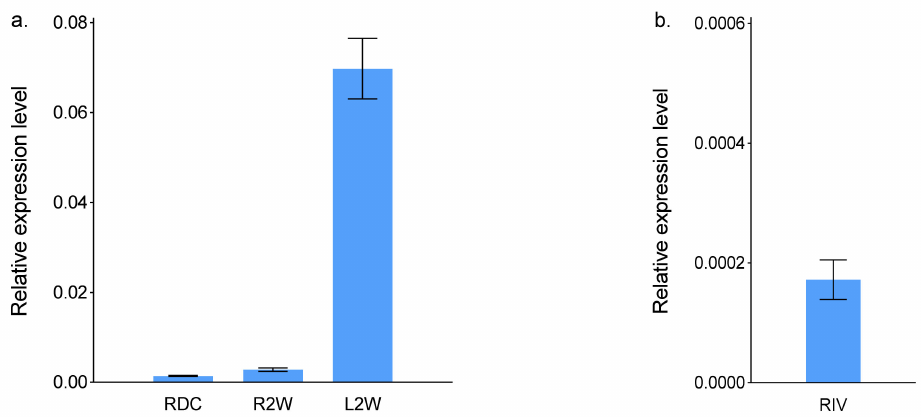
Figure 1. Relative transcript levels of ScBx1 in ( a ) roots developed from seeds deprived of coleoptile 2 days after sowing (RDC), roots (R2W) and leaves (L2W) of 2-week-old seedlings; ( b ) roots developed in vitro (RIV) of rye inbred line L318. Data are mean ± SD of three biological